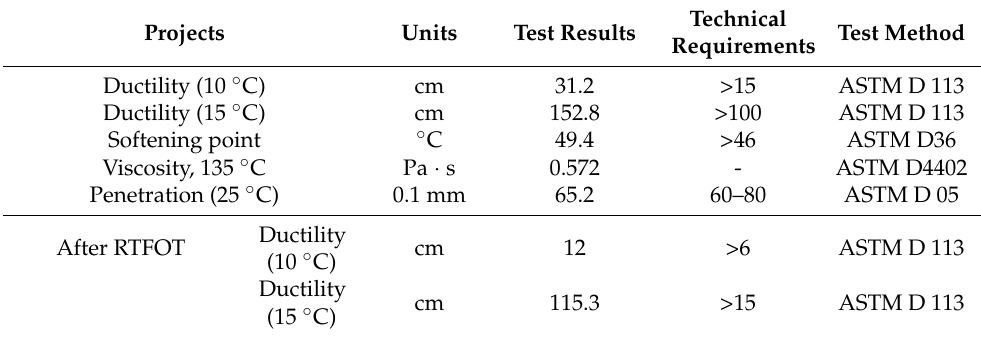
Table 1. Basic properties of base asphalt.